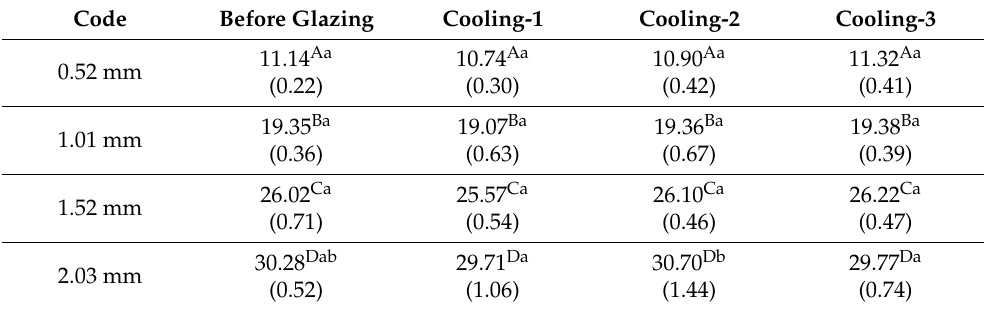
Table 8. Opalescence parameter (OP) for each group of the zirconia specimens with different thick- nesses (mean ±